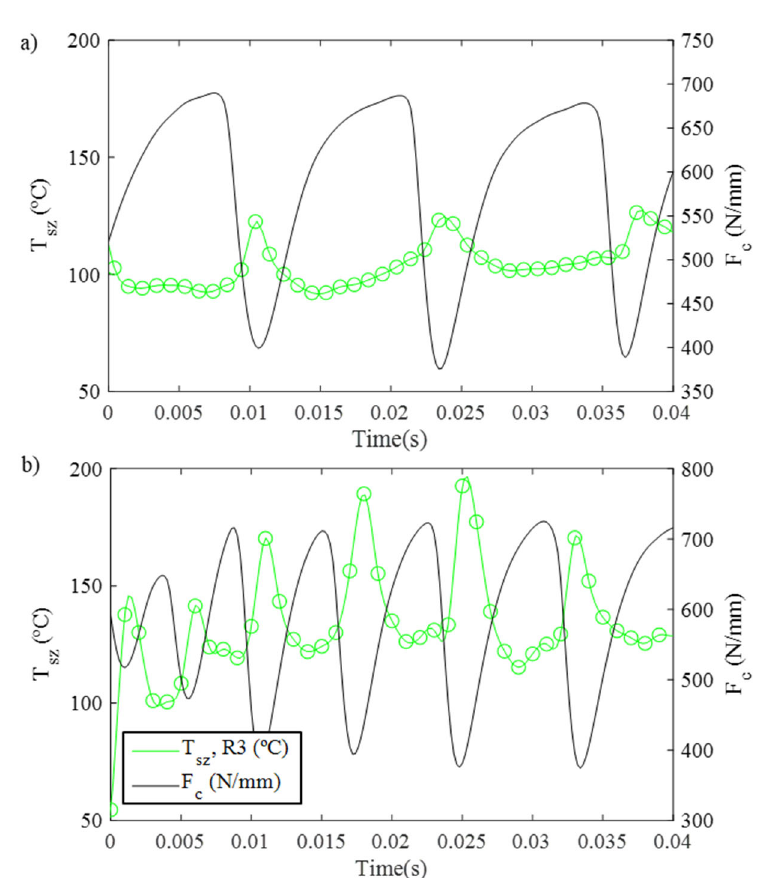
Figure 9. Experimental measurements of temperature and force evolution during orthogonal cutting of Ti6Al4V. ( a ) V c = 2.5 m/min and f = 0.4 mm; ( b ) V c = 7.5 m/min and f = 0.4 mm.